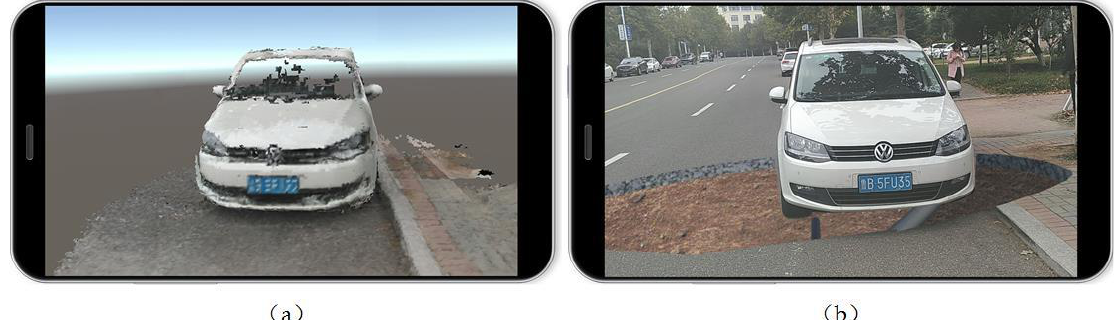
Figure 12. Underground pipeline based on 3D reconstruction occlusion: ( a ) the 3D reconstruction of the environment; ( b ) effect of transparent occlusion material treatment.